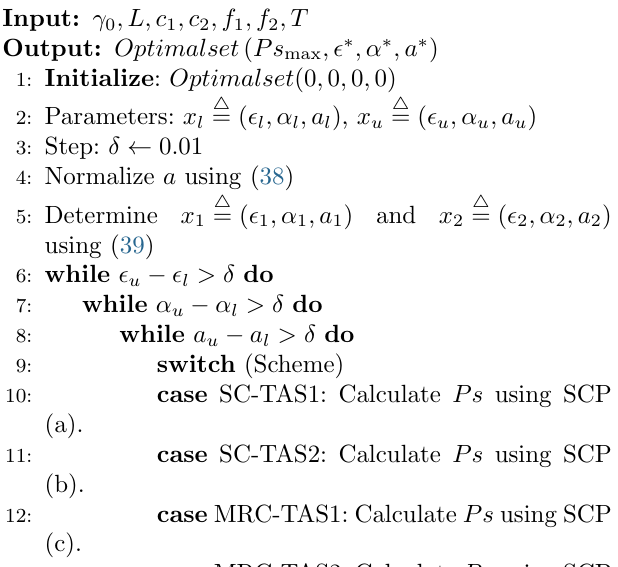
Algorithm 2 Successful computation probability maximization searching (SCPMS) algorithm